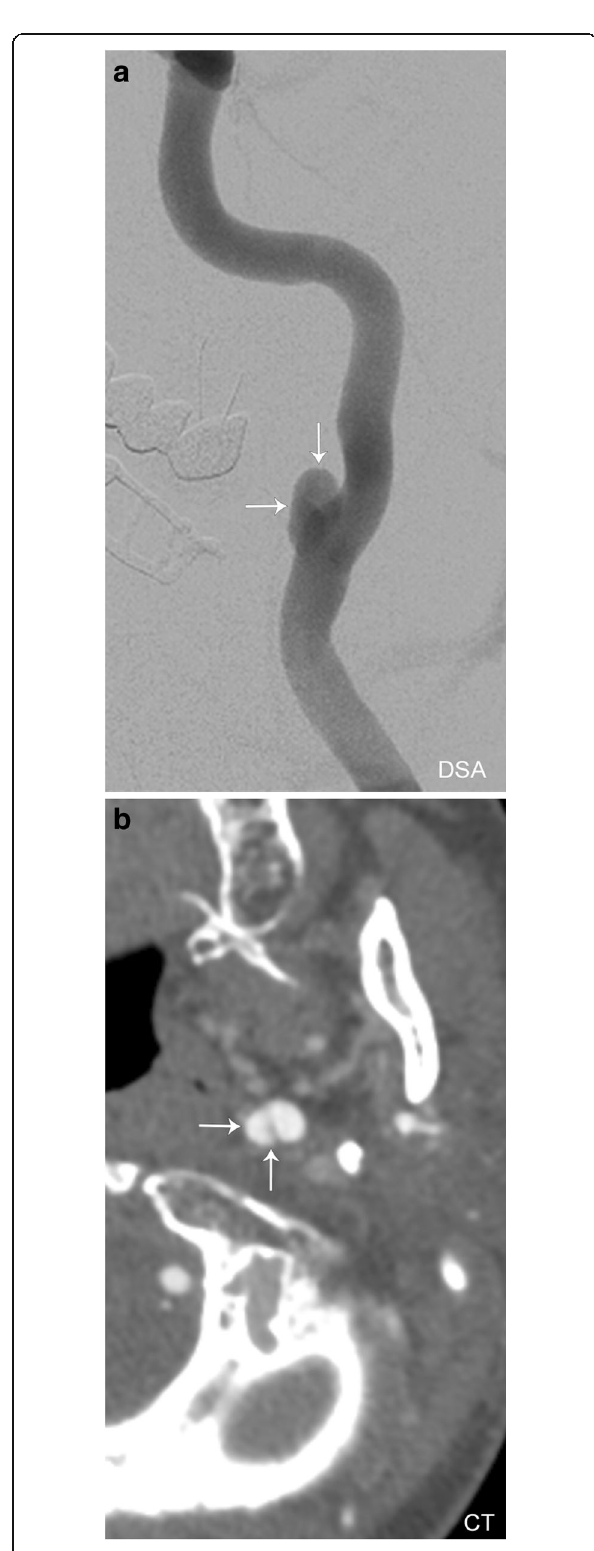
Fig. 15 Iatrogenic pseudoaneurysm. a Conventional angiogram and b axial CT angiogram images demonstrating the appearance of a pseudoaneurysm (white